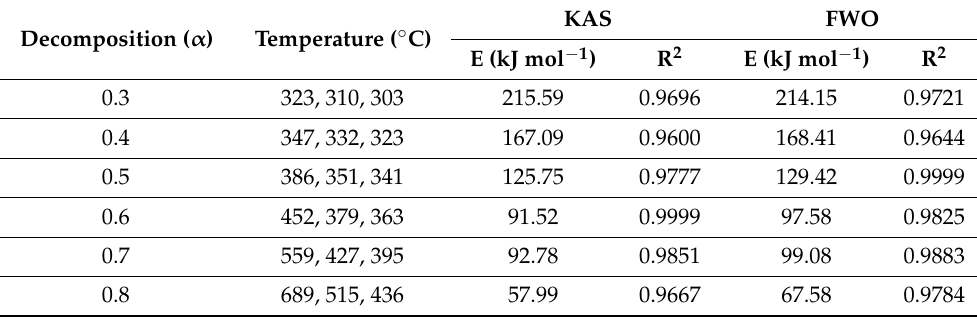
Table 4. Activation energy obtained from KAS and FWO models for both samples’